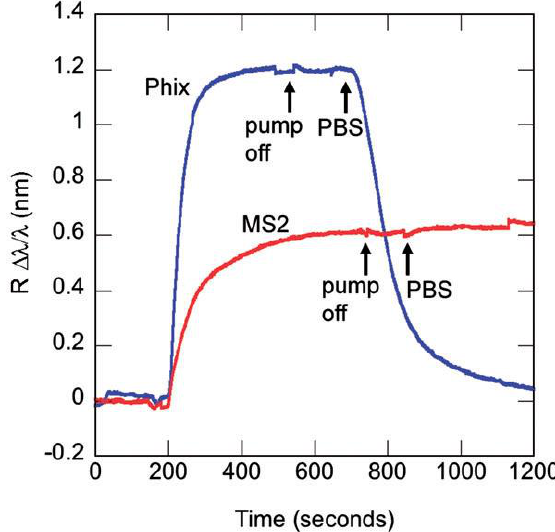
Figure 14. Comparison between Phix174 (blue line) and MS2 (red line) detection experiments on the same microspherical WGMR [21]—Reproduced by permission of The Royal Society of Chemistry.